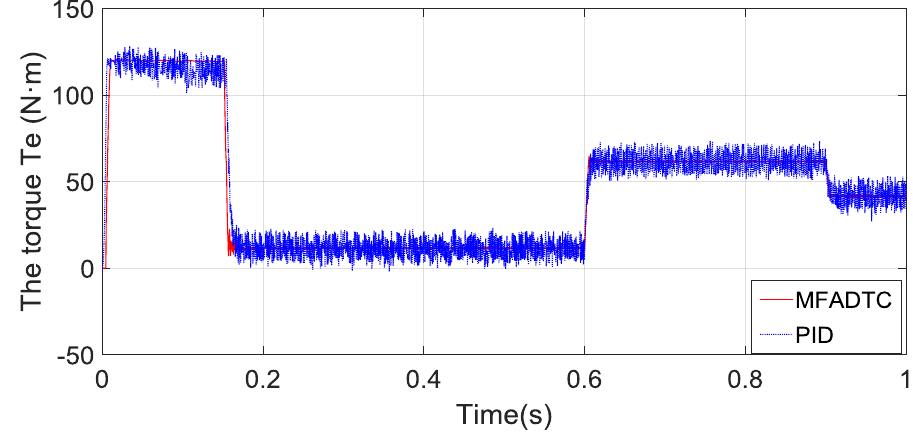
Figure 7. Comparison of torque pulse between PID and MFADTC. Table 2. MSE indices with disturbance.